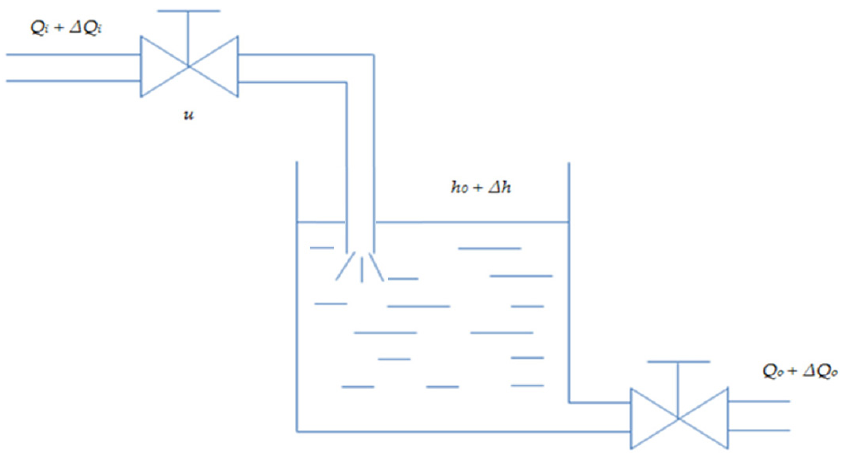
Figure 1. Single water tank. Adapted with permission from [13].